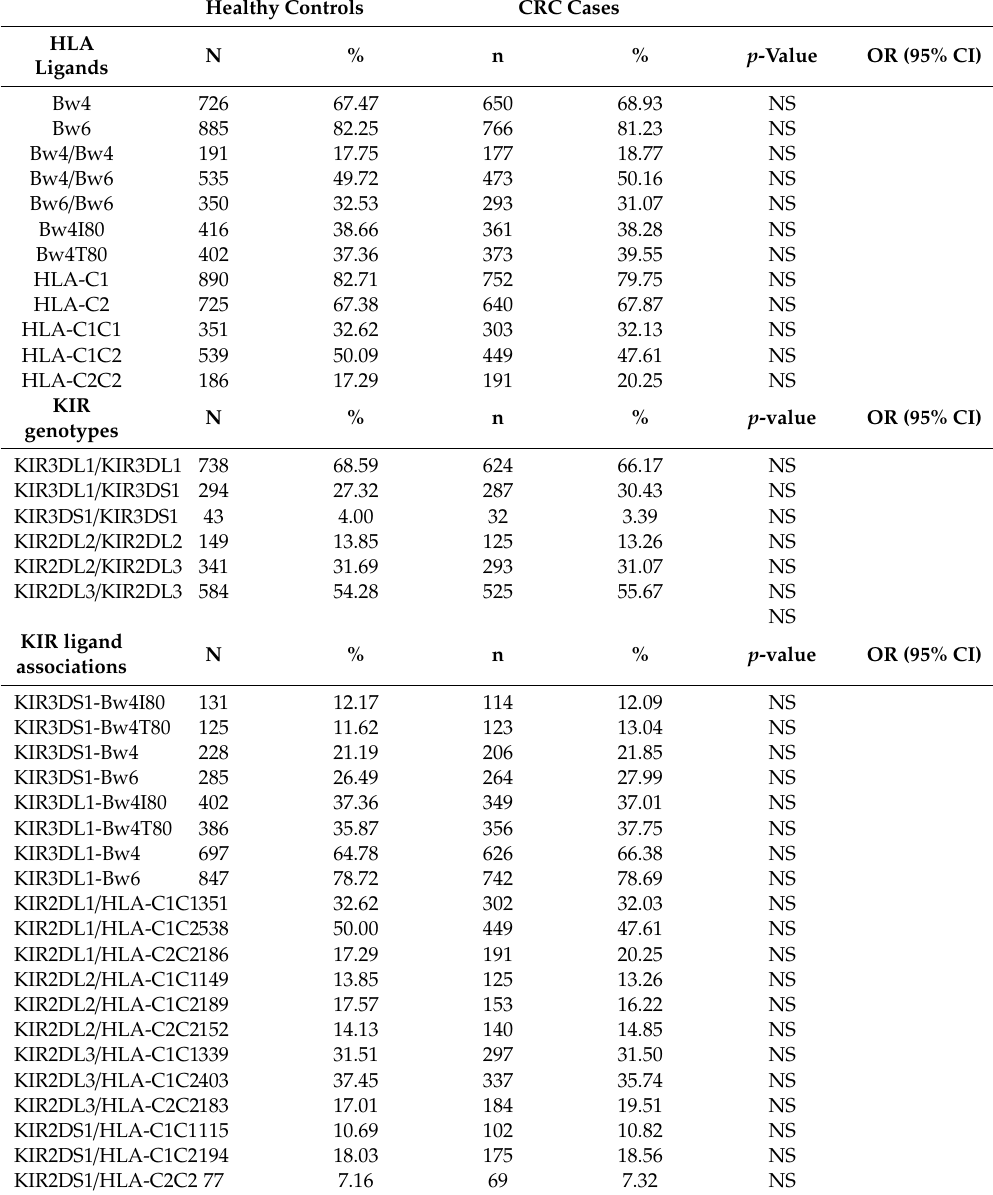
Table 5. Distribution of HLA ligands frequencies and KIR-HLA interactions in CRC cases and healthy